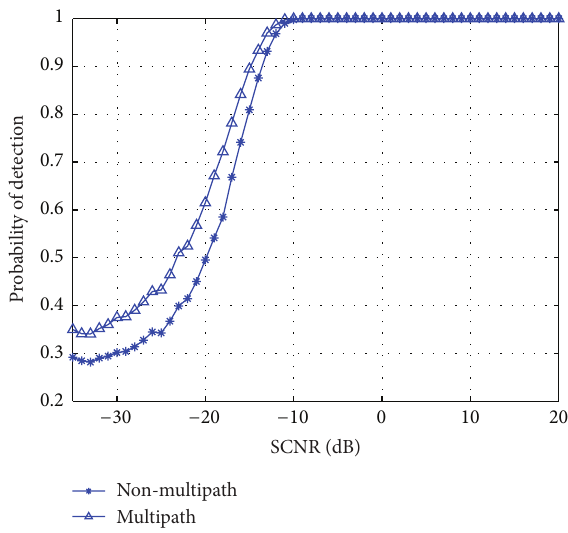
Figure 4: GLRT detector performance in low-grazing